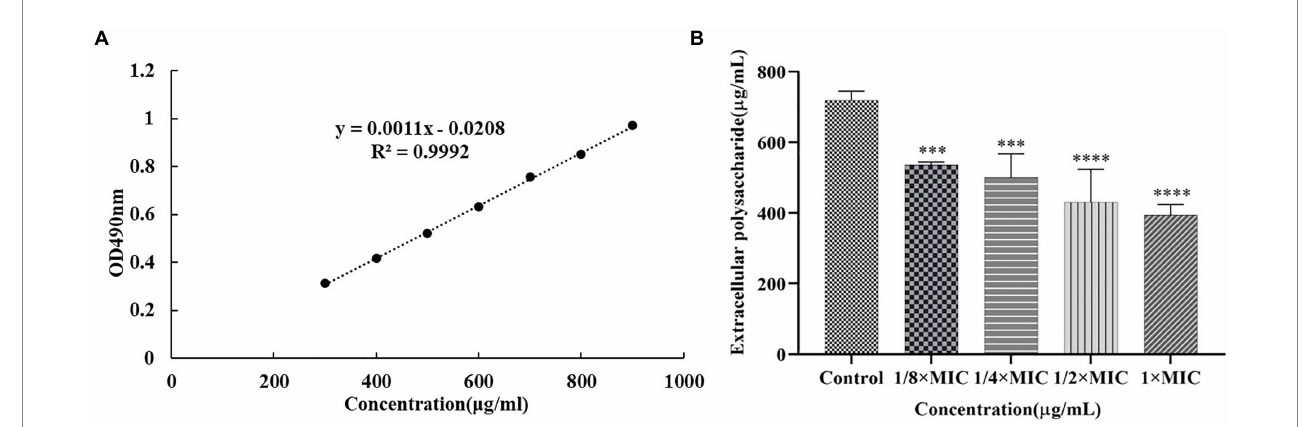
FIGURE 7 Effect of Disaspidin BB on the biofilm extracellular polysaccharide of SEP-05. (A) glucose standard curve. (B) Changes in the amount of biofilm extracellular polysaccharides of SEP-05 by Disaspidin BB administration. *** means p < 0.001. **** means p <